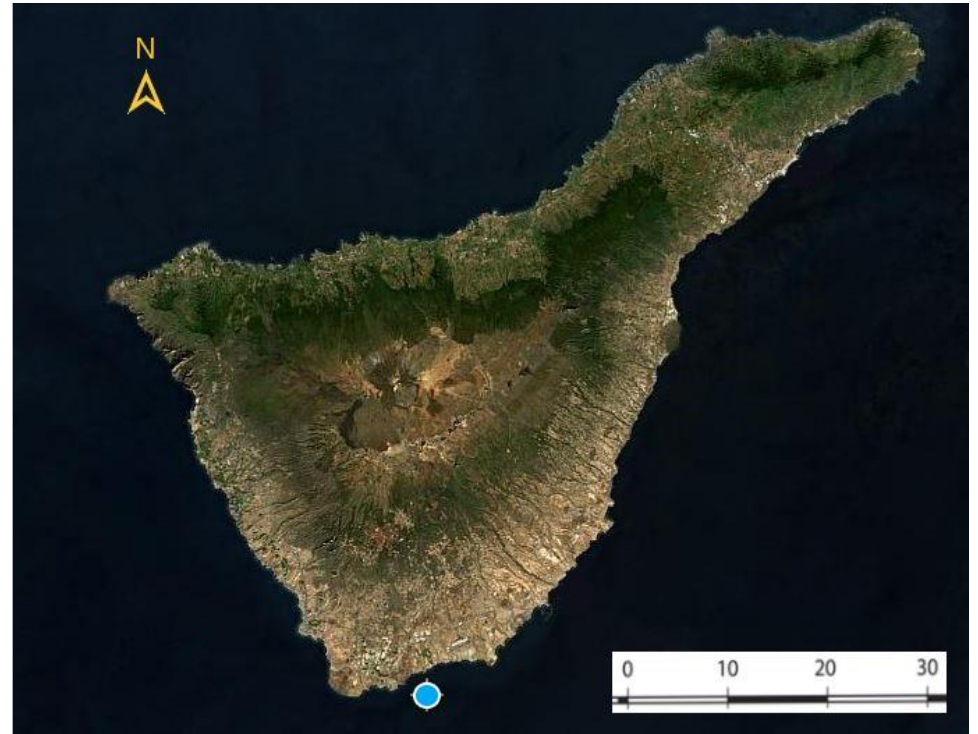
Figure 2. Position of the Tenerife Sur buoy (white–blue), located off the south of the island of Tenerife. Scale in km.